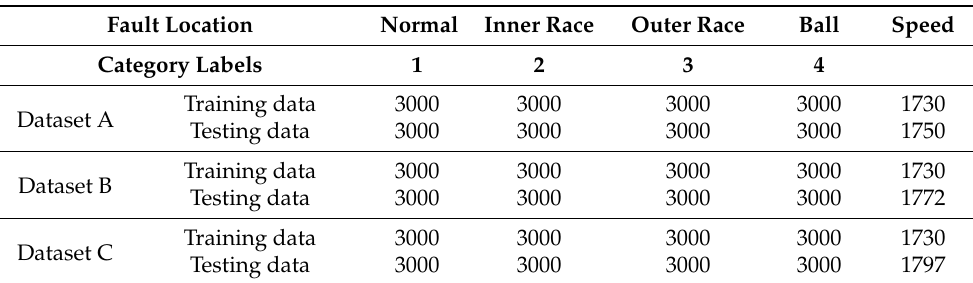
Table 3. The datasets used in experiment